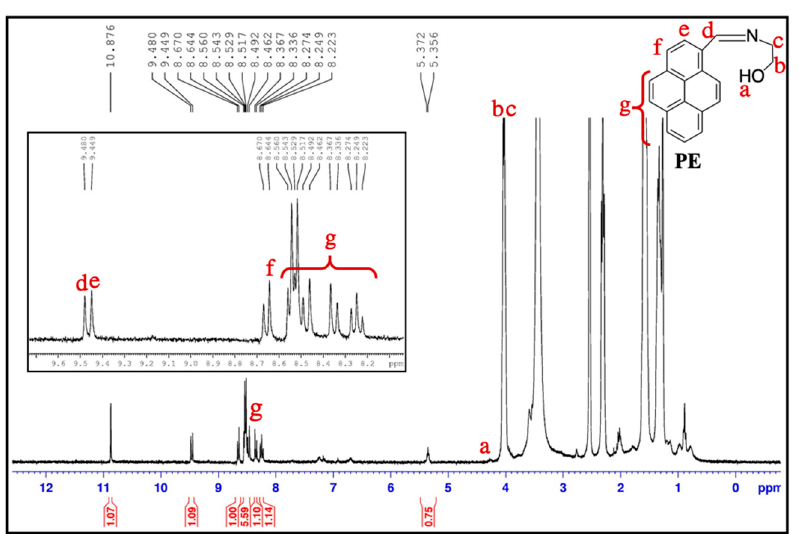
Figure 3. 1 H nuclear magnetic resonance (NMR) spectra of PE/MNPs microcapsules in DMSO.